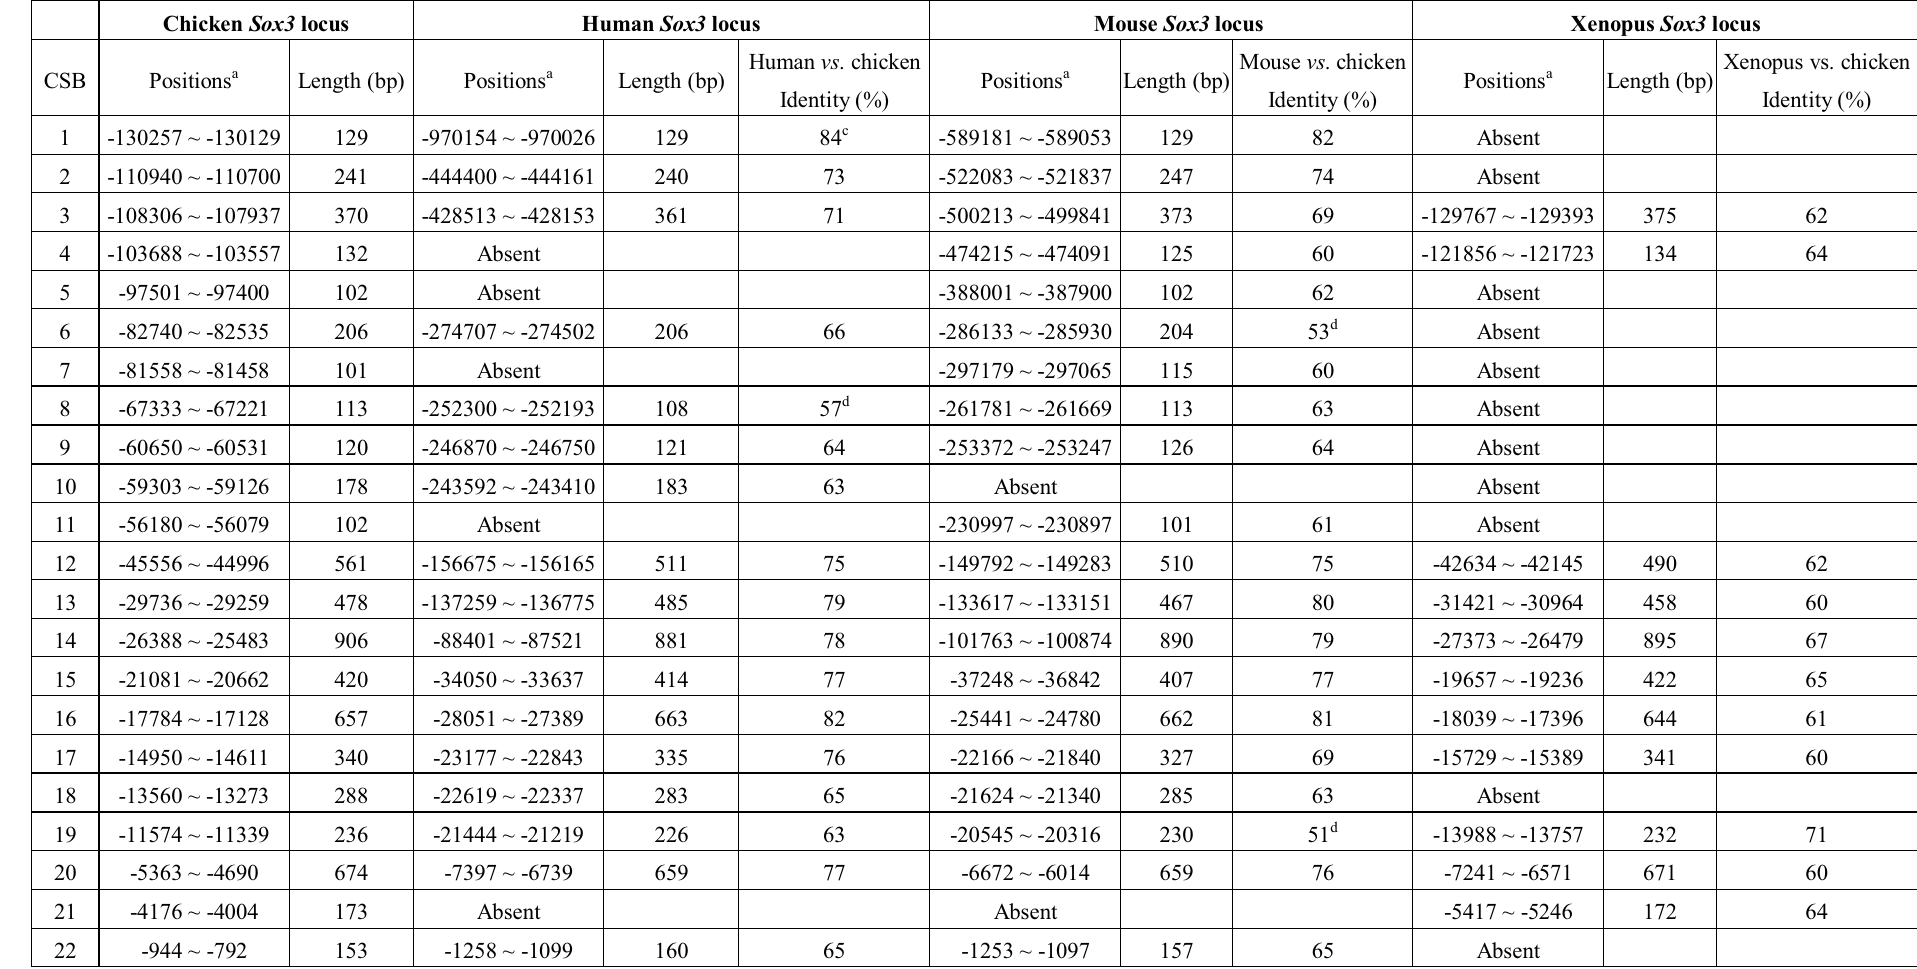
Table S1. Positioning of the conserved sequence blocks (CSBs) in the human, mouse, chicken and Xenopus